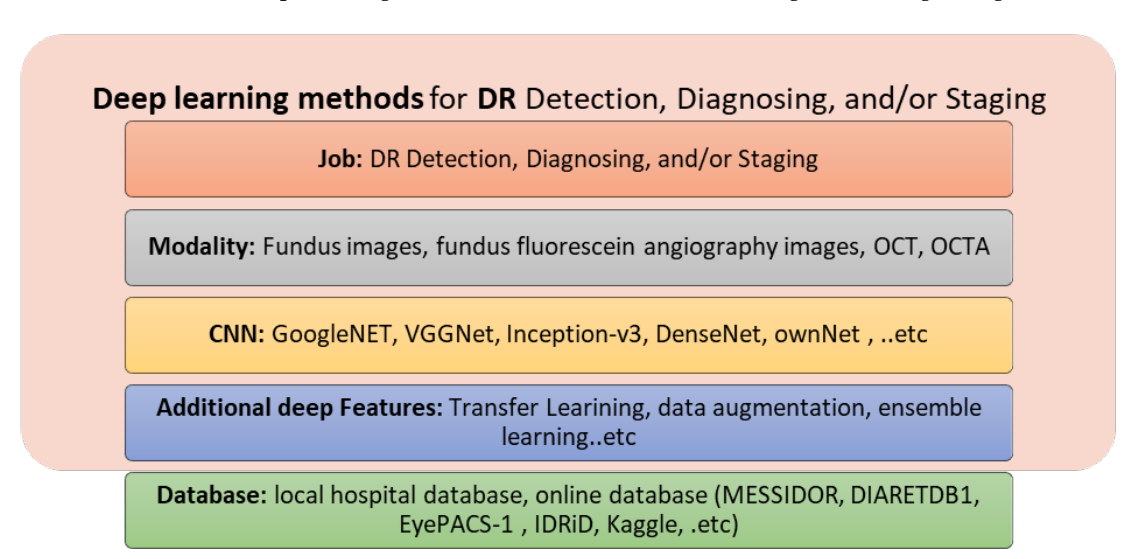
Figure 6. Summary of deep learning methods for DR detection, diagnosis, and/or staging. For fundus images, different deep learning methods have been applied. For example, Gulshan et al. [155] used an ensemble of 10 CNN networks for the grading of DR and DME using fundus images. The final decision of the ensemble was computed as the linear average of the predictions of the ensemble. Colas et al. [156] graded DR using a deep CNN network applied on fundus images. Their technique provided the location of the detected anomalies. Ghosh et al. [25] applied data augmentation, normalization, and denoising preprocessing stages. Then, a 28-layer CNN was applied for the grading of DR